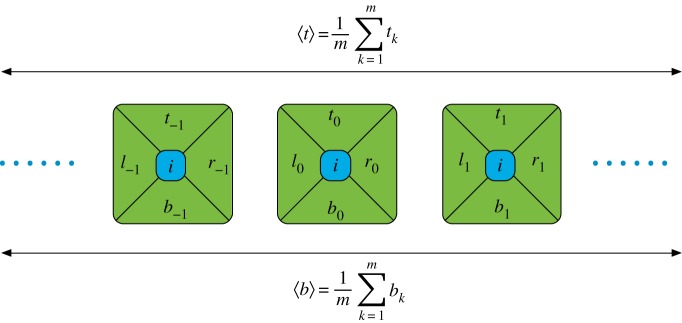
Law of averages for a segment of Kari tiles. For large m, f(〈t〉) ≈ 〈b〉. (Online version in colour.)